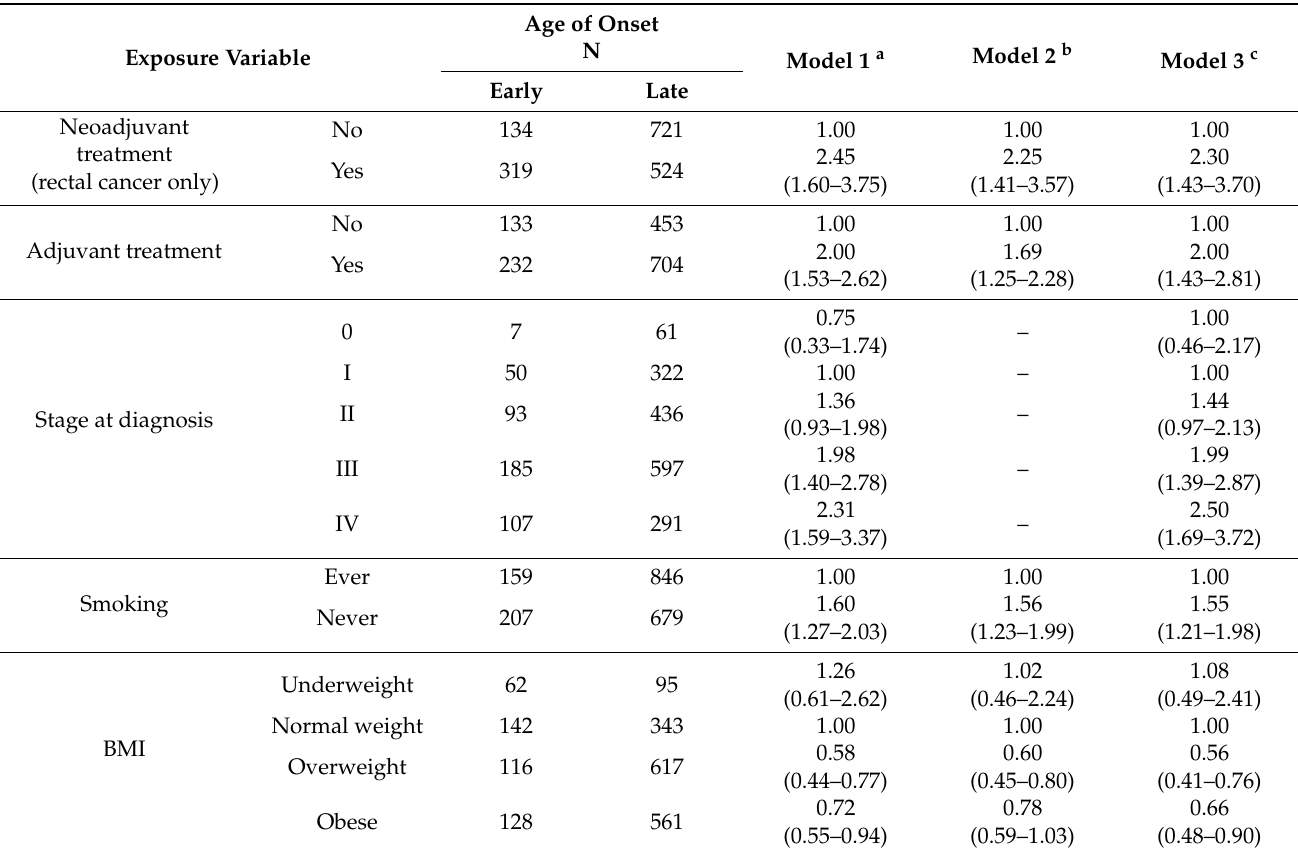
treatment. Early-onset colorectal cancer patients were less likely to be overweight and obese compared to patients with late-onset colorectal cancer (OR (95% CI) comparing early- to late-onset = 0.56 (0.41–0.76) and 0.66 (0.48–0.90), for overweight and obese patients, respectively). Early-onset patients were more likely to be never smokers compared to